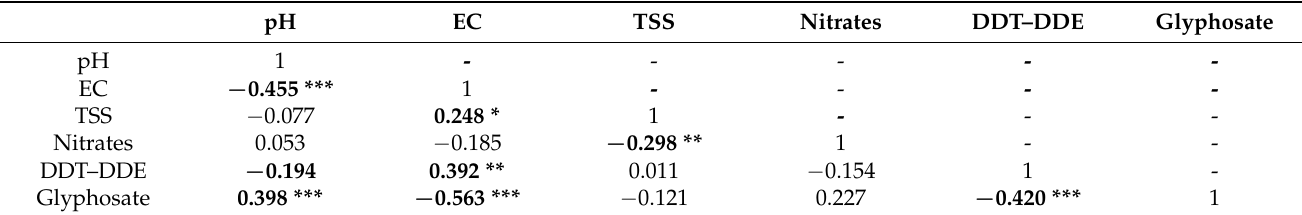
Table 2. Spearman rank correlation test results. Significant correlations are highlighted in bold.